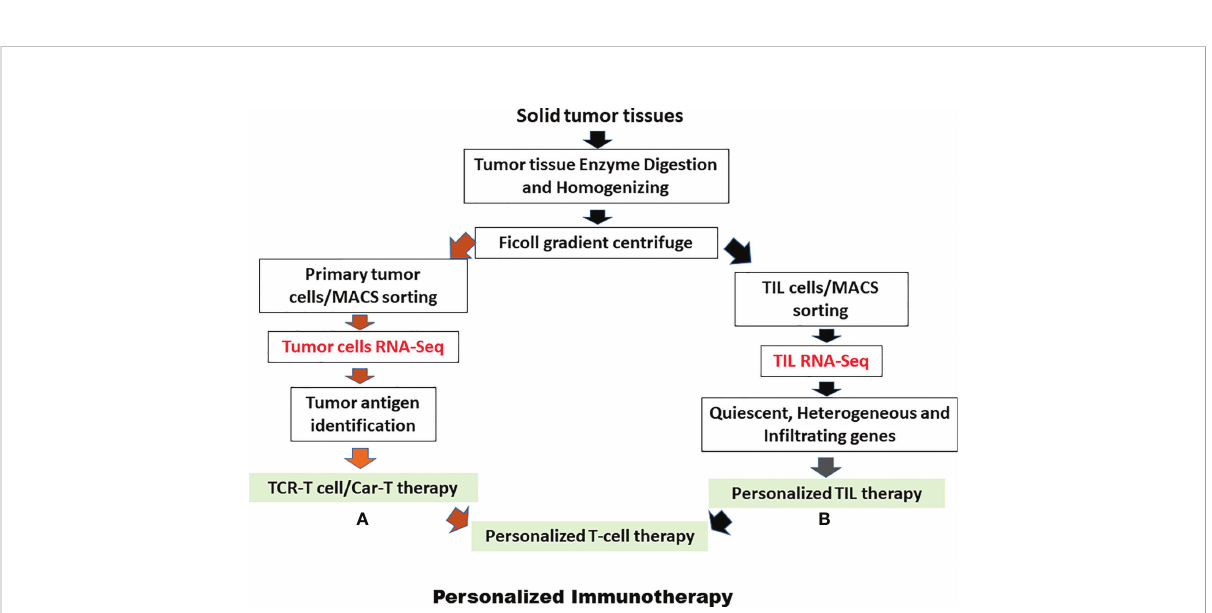
FIGURE 4 Personalized TIL therapy or personalized T-cell therapy. (A) Harvesting tumor cells from solid tumor tissues to run RNA-seq to discover neo- antigen or other related genes. (B) Harvesting TILs from solid tumor tissues to run RNA-seq to discover quiescent genes, heterogamous response genes, and in fi ltrating and homing genes. A pink arrow represents primary tumor cell procedures for performing personalized immunotherapy and a dark arrow represents TIL procedures for performing personalized TIL immunotherapy. Red represents running RNA-seq for both TIL and primary tumor